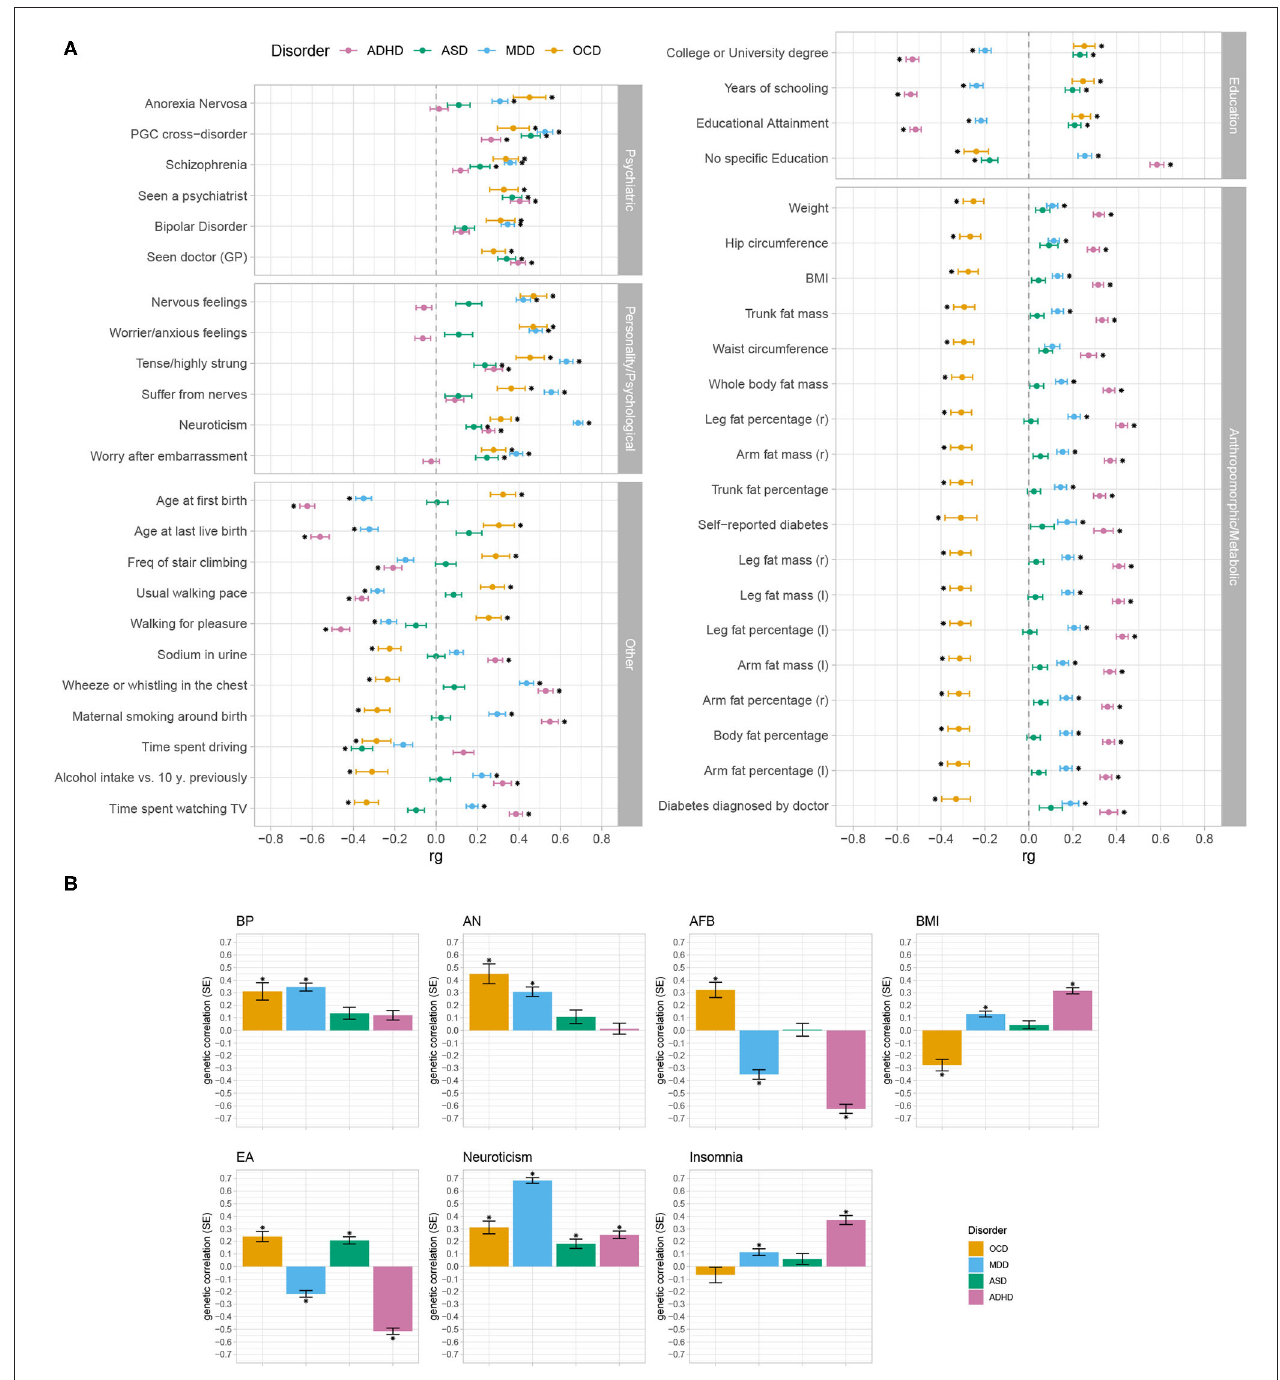
FIGURE 2 | Genetic correlation patterns of OCD, MDD, ADHD, and ASD with a wide range of other phenotypes. Bivariate LD score regression (LDSC) was used for the analysis, either as implemented in LDhub or using LDSC. Error bars represent standard errors and asterisks indicate significant associations after Bonferroni-correction (significance threshold of 6.42 × 10 − 5 , corrected for 779 tests) for multiple testing. (A) Displayed are all traits ( N = 45) that significantly correlated with OCD (yellow), and the respective genetic correlation estimates for MDD (blue), ADHD (pink), and ASD (green), grouped into five different domains (psychiatric, personality/psychological, other, education, and anthropomorphic/metabolic). (B) Shows the genetic correlation estimates of OCD (yellow), MDD (blue), ADHD (pink), and ASD (green) with the seven phenotypes (bipolar disorder (BP), anorexia nervosa (AN), Age of first birth (AFB), body-mass index (BMI), educational attainment (EA), neuroticism, and insomnia) that were selected for subsequent PRS analyses. Here, bar-plots were used to enable easier comparison with the results from the PRS analyses (see Figure 3 ). See Supplementary Table 3 for a list of all estimates and references for all used phenotypes. Asterisks indicate significant associations after Bonferroni-correction (significance threshold of 6.42 × 10 − 5 , corrected for 779 tests) for multiple testing).